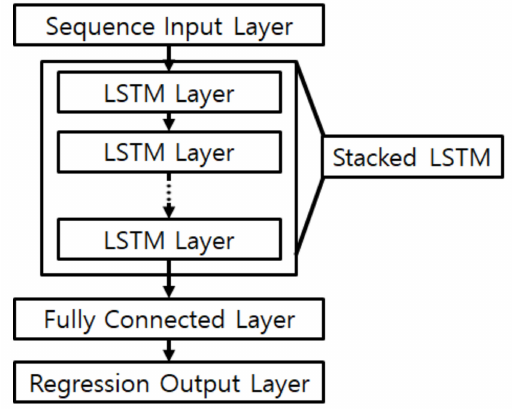
Figure 1. Architecture of the proposed neural network for movement path data.